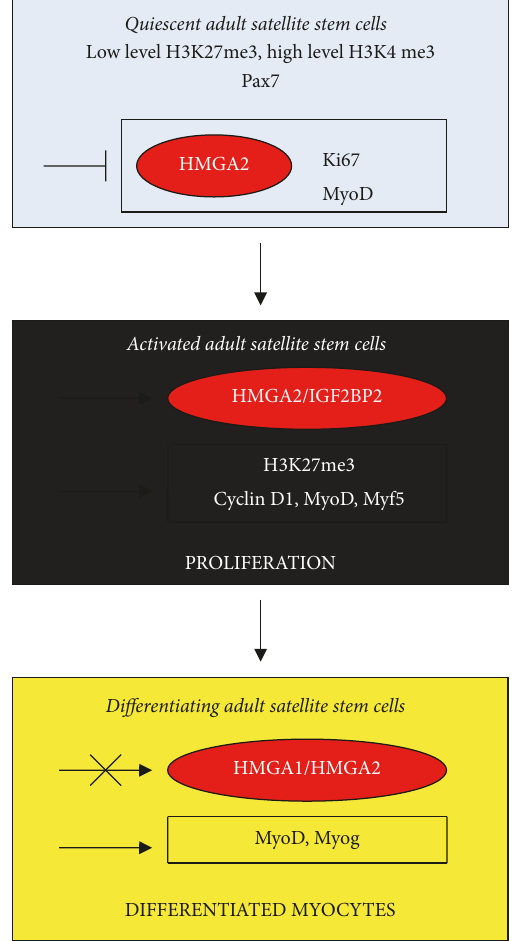
Figure 7: From quiescent adult satellite stem cells to differentiated myocytes. Symbols are the same as shown in Figure 1.